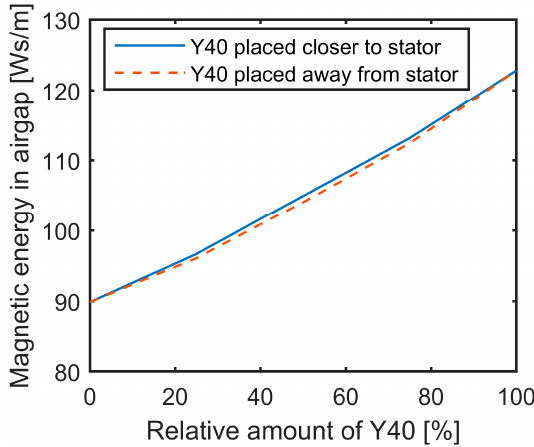
Figure 6. The magnetic energy per unit stack length in the airgap (Ws/m) for relative amount of Y40.